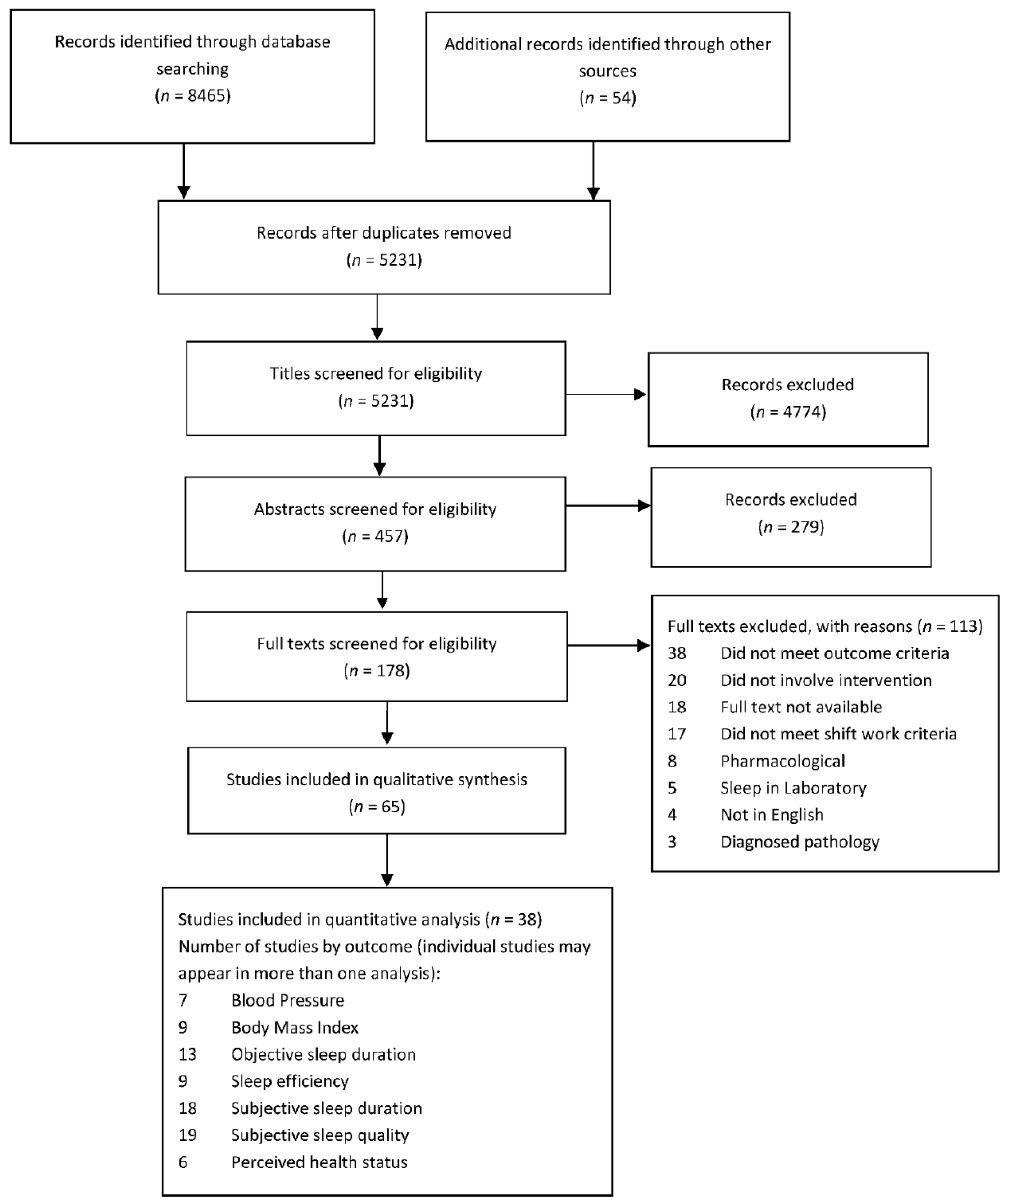
Figure 1. PRISMA flowchart for selection of studies included in review .